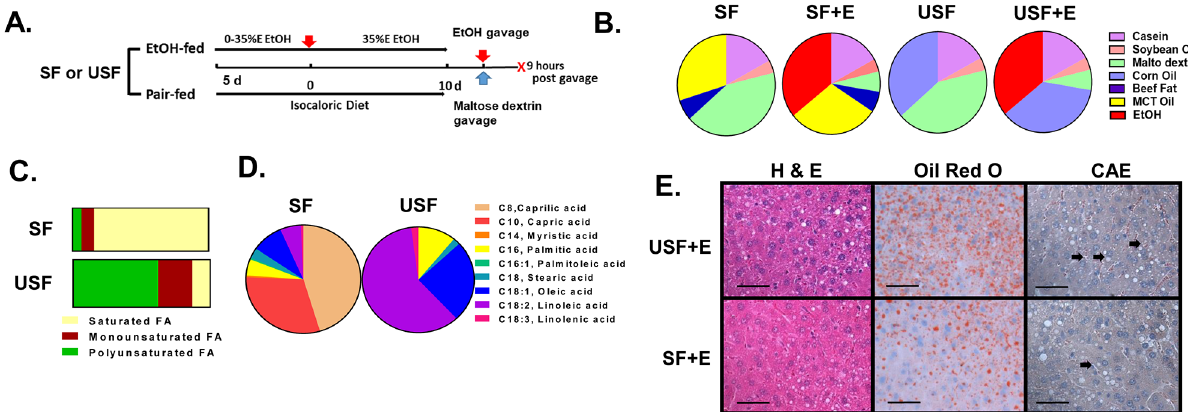
Fig 1. Characterization of liver injury caused by chronic-binge ethanol exposure. A: Schematic presentation of the chronic-binge ethanol exposure protocol. C57BL/J mice were fed control (pair-fed) or ethanol diets for 10 days, followed by single gavage of maltose dextrose or ethanol on day 11, respectively. Animals were euthanized 9 hours after gavage. B: The composition of the experimental liquid diets. The SF diet was enriched in beef tallow fat and MCTs (18:82 ratio). The USF diet was enriched with corn oil. Soybean oil was used in both diets to provide essential free fatty acids. The control (SF and USF) diets contained 43% of calories from carbohydrate, 17% from protein, and 40% from fat. The SF and ethanol and USF and ethanol diets contained 35% of calories from ethanol to replace the calories from carbohydrate. C: The percent of saturated, monounsaturated and polyunsaturated fatty acids was 84.1%, 9.9%, and 6.6% in SF diet and, 13.1%, 25.0%, and 61.9% in USF diet, respectively. D: Fatty acid composition of experimental diets. E: Representative images of hepatic hematoxylin and eosin (H&E), Oil Red O and chloroacetate esterase (CAE) staining. Original magnification, x400, scale bars are 50 μ m. Arrows indicate CAE-positive